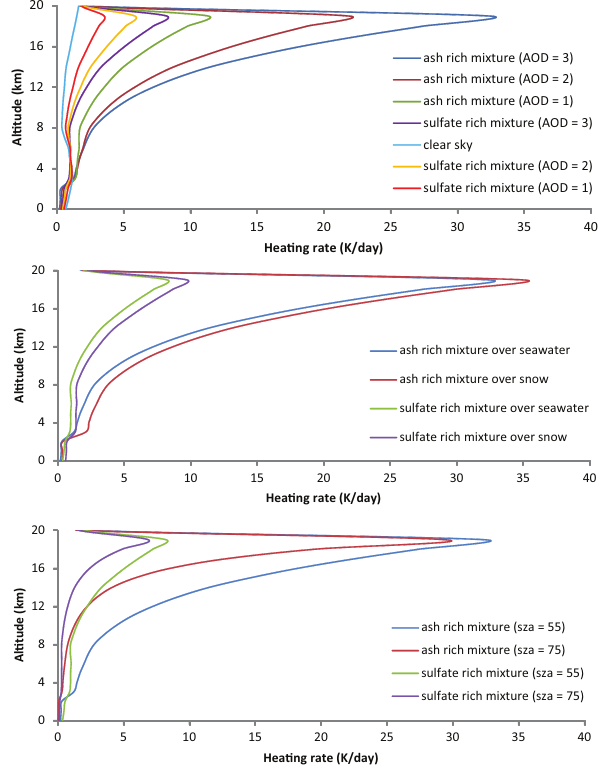
Fig. 12. (a) The effect of aerosol composition and AOD(550nm) of a thick plume ( ∼ 3–20km) on SW heating rate. SZA = 55 ◦ and surface type is seawater for all cases. (b) The effect of aerosol com- position of a thick plume ( ∼ 3–20km) and surface type on SW heat- ing rate. SZA=55 ◦ and AOD(550nm)=3 for all cases. (c) The effect of aerosol composition of a thick plume ( ∼ 3–20km) and so- lar zenith angle (SZA) on SW heating rate. The AOD(550nm)=3 and the surface type is seawater for all cases.